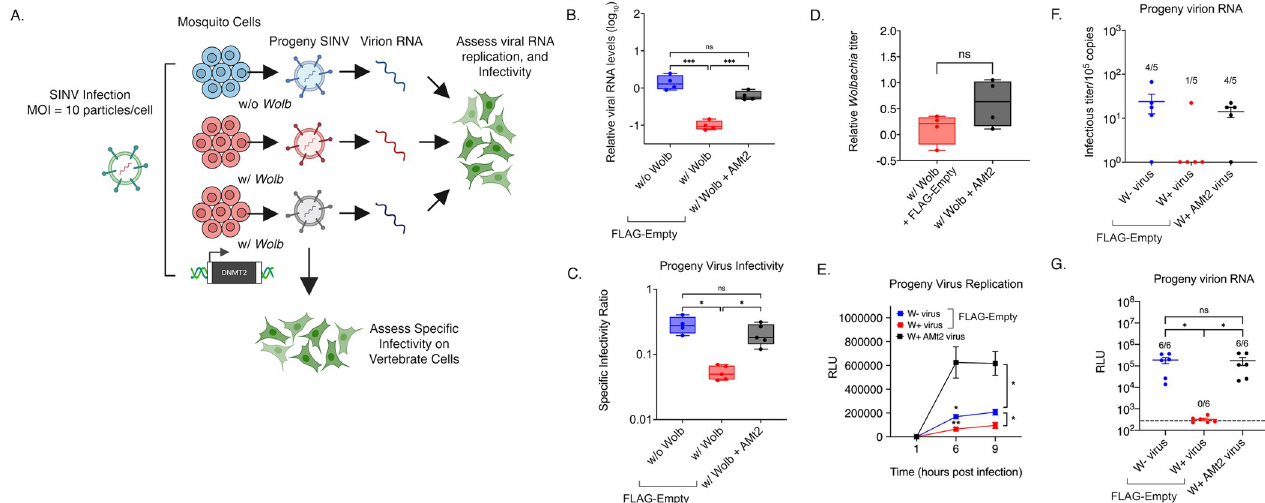
Fig 4. AMt2 overexpression in Wolbachia- colonized cells rescues virus from endosymbiont-mediated inhibition. C7/10 cells with Wolbachia were transfected with expression vectors FLAG-empty (w/ Wolb) or FLAG-AMt2 (w/ Wolb + AMt2) for 48 hours prior to infection with SINV-nLuc at MOI of 10. Wolbachia - free cells expressing FLAG-empty (w/o Wolb) were used as a positive control. (A) Schematic of experimental workflow. (B) Viral genome replication in C7/10 cells was quantified using qRT-PCR using extracted total RNA from infected cell lysates. One-way ANOVA with Tukey’s post-hoc test of multivariate comparison. (C) Specific Infectivity Ratios of progeny viruses produced from the aforementioned infection was calculated as described earlier [1]. Briefly, infectious progeny viruses collected from supernatants 48 hours post infection were quantified using plaque assays on BHK-21 cells, while total number of progeny virus particles was quantified via qRT-PCR of viral genome copies released into the supernatant. Error bars represent standard error of mean (SEM). One-way ANOVA with Tukey’s post-hoc test of multivariate comparison, w/ Wolb vs w/ Wolb + AMt2, p = 0.0003, w/o Wolb vs w/ Wolb, p < 0.0001. (D) C7/10 mosquito cells with Wolbachia were transfected with expression vectors FLAG-empty (w/ Wolb) or FLAG-AMt2 (w/ Wolb + AMt2) for 48 hours prior to quantification of endosymbiont titer via quantitative PCR using DNA from extracted cell lysates. Error bars represent standard error of mean (SEM). Unpaired, student’s t-test, p = 0.1316, t = 1.794, df = 5.097. Statistically non-significant values are indicated by ns. (E) Progeny viruses were used to synchronously infect na ï ve BHK-21 cells at equivalent MOIs of 5 particles/cell. Cell lysates were collected at indicated times post infection and luciferase activity (RLU), was used as a proxy for viral replication. Two-way ANOVA with Tukey’s post-hoc test of multivariate comparison, Time: p < 0.0001, Wolbachia/AMt2 : p = 0.0003, Time x Wolbachia/AMt2 : p < 0.0001. (F) Approximately 10 5 copies (determined using qRT-PCR) each of virion encapsidated RNA extracted from the aforementioned W+, W+ AMt2 and W- viruses were transfected into na ï ve BHK-21 cells and infectious titer was determined by the counting the number of plaques produced after 72 hours post transfection. Numbers above bars refer to the proportion of samples that formed quantifiable plaque-forming units on BHK-21 cells. One-way ANOVA with Tukey’s post-hoc test of multivariate comparison. (G) 10 5 copies each of virion encapsidated RNA extracted from the W+, W+ AMt2 and W- viruses were transfected into na ï ve BHK-21 cells and luciferase activity (RLU) was used as a proxy for viral replication at 9 hours post-transfection. Numbers above bars refer to the proportion of samples that produced luciferase signal above background levels, indicated by the dotted line. One-way ANOVA with Tukey’s post-hoc test of multivariate comparison, w/ Wolb vs w/ Wolb + AMt2: p < 0.00001, w/o Wolb vs w/ Wolb: p < 0.0001; w/o Wolb vs w/ Wolb + AMt2: p = 0.991. For all panels error bars represent standard error of mean (SEM). � P < 0.05; �� P < 0.01; ���� P < 0.0001. Graphical assets were made in BioRender (https://biorender.com).